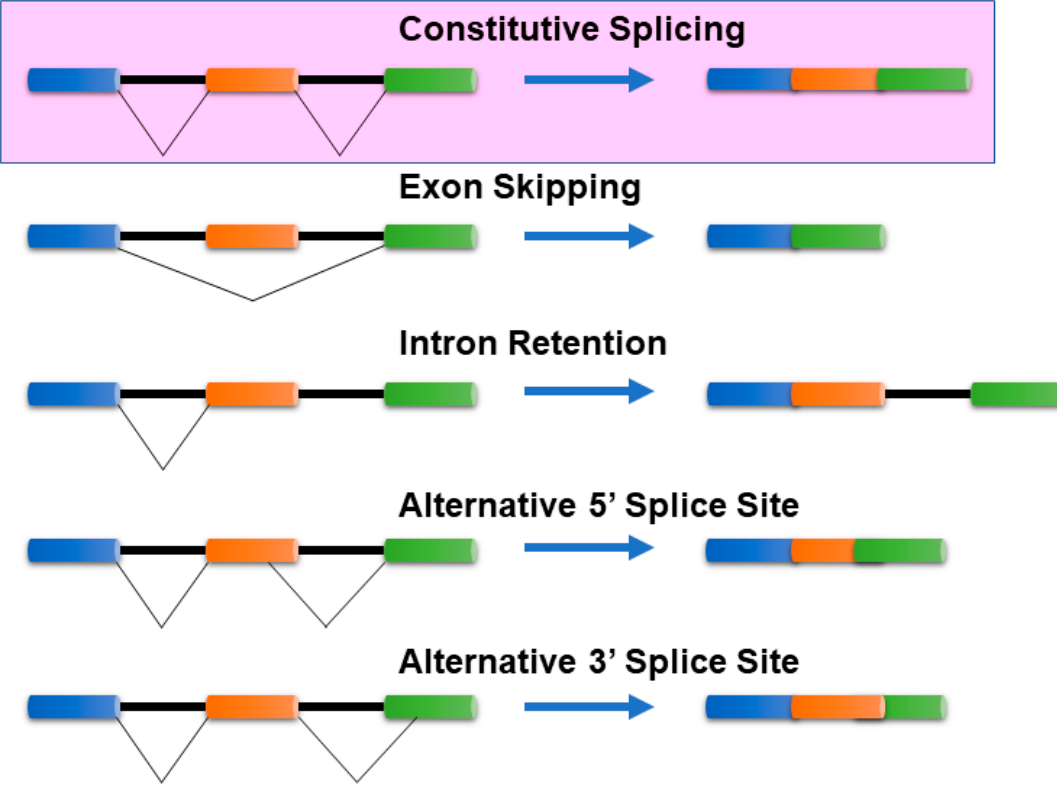
Figure 1. Common Alternative splicing events. The mechanisms of the most common alternative splicing events: Exon Skipping, Intron Retention, Alternative 5 ′ splice site selection, and Alternative 3 ′ Splice Site selection, are presented. There are several other alternative splicing events that are not shown here. The colored bars (blue, orange, and green) represent exons, while the black lines connecting them represent intronic segments. Exon skipping—The most prevalent mechanism in vertebrates and invertebrates where specific exons in the pre-mRNA are skipped in the mature mRNA transcript. Intron retention—Common in lower metazoans and plants, it is a process where an intron is retained in the mature mRNA, and Alternative 3 ′ /5 ′ acceptor/donor sites—A process that involves exons that are flanked by competing splice sites on one end (3 ′ /5 ′ ) and a fixed splice site on the opposite end, resulting in an alternative region that is either included or excluded in the mature mRNA.